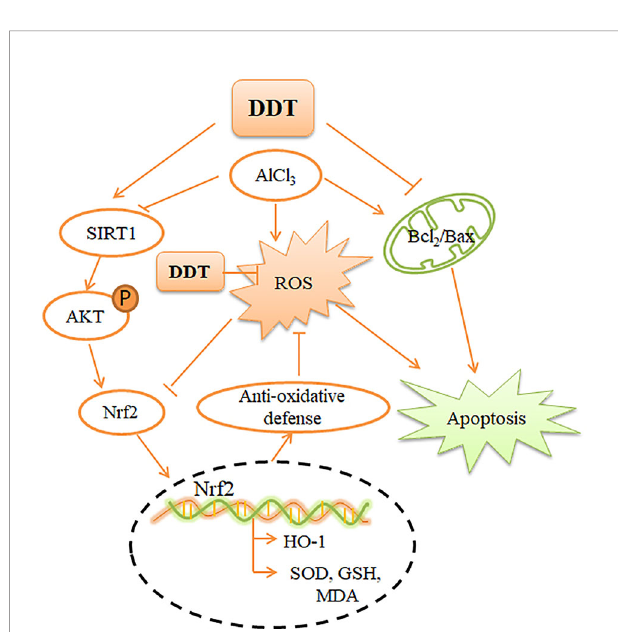
FIGURE 8 | Mechanism by which DDT inhibits oxidative stress and apoptosis in PC12 cells. AlCl 3 -induced intracellular ROS accumulation, which causes intracellular oxidative stress and apoptosis. DDT up-regulates SIRT1- mediated PI3K/Akt signaling, which causes Nrf2 expression and nuclear translocation. Nrf2 activation enhances the downstream, HO-1 expression, which fi nally protects cells from oxidative stress and